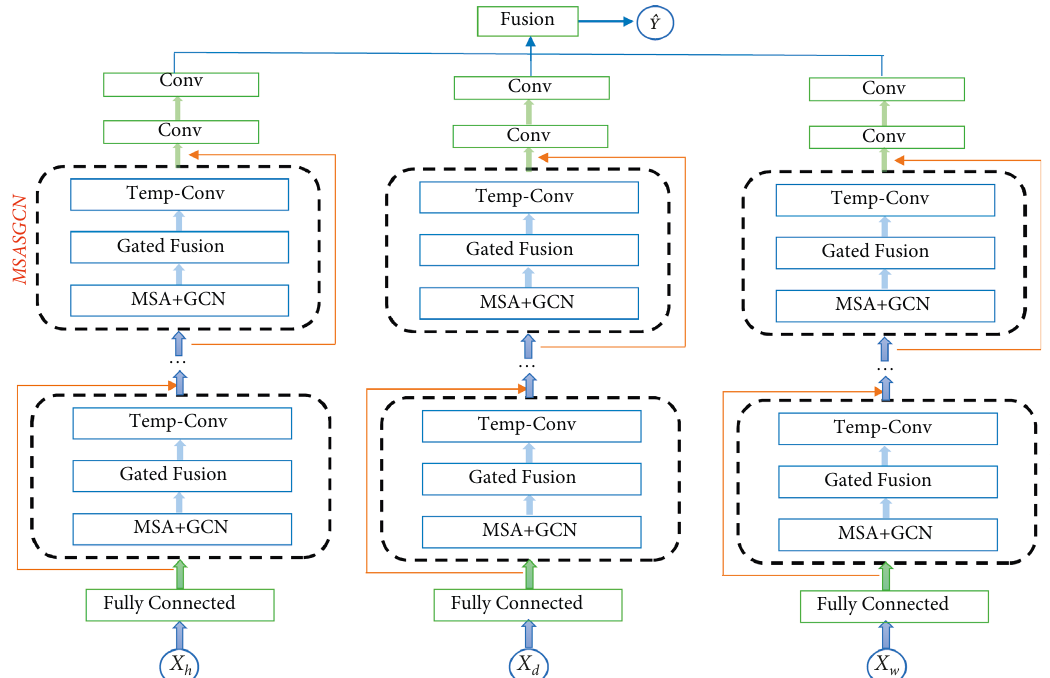
Figure 4: Extended MSASGCN architecture with weekly and daily period time dependencies. MSA :Multi-head self-attention; GCN: graph convolutional network; Temp-Conv : temporal convolution; Conv: